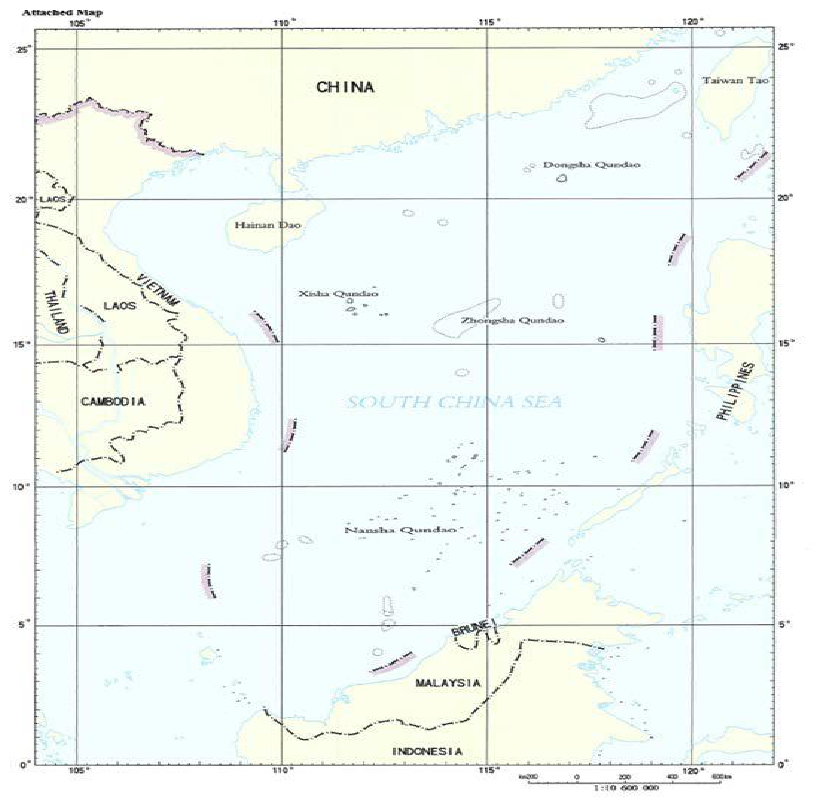
Figure 1: Nine Dash Line Map(Baumert,